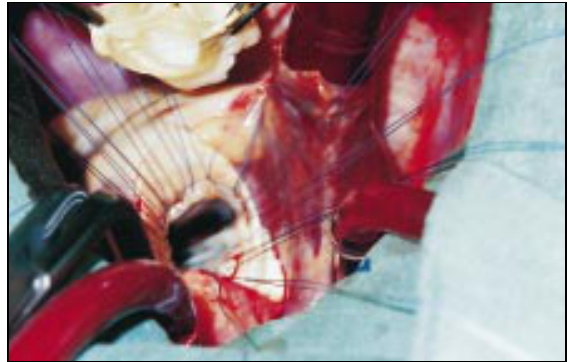
Fig. 2 – Passagem dos pontos na borda inferior da bioprótese aórtica “stentless”, destacando-se o posicionamento dos fios comissurais na porção inferior de cada pilar.